Question: What does this figure show? Answer in one sentence.
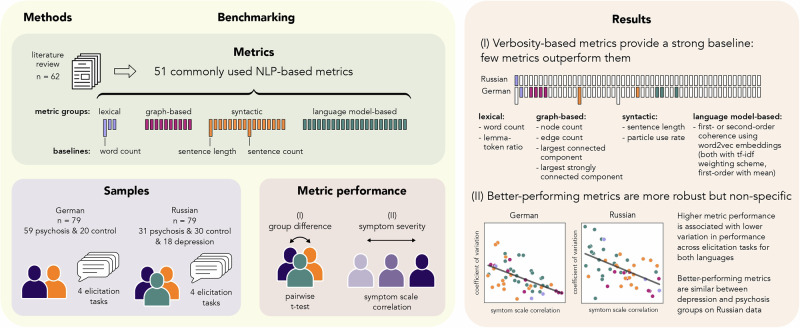
Answer: The study framework for benchmarking the commonly used NLP-based psychosis detection methods and an overview of the main findings. Methods . Samples Two datasets of speech samples were used in this study, one with German and one with Russian-speaking participants. Each sample included a group of participants with psychosis as well as a healthy control group and, for the Russian data, a clinical control group of patients with affective disorders with predominantly depressive symptoms. Four different elicitation tasks were used to obtain four texts per participant. Metric performance Two definitions of metric performance for psychosis detection were used, (i) group difference detection measured with a t-test and (ii) symptom severity assessment measured as correlation with symptom scale scores. Benchmarking 51 commonly used NLP-based metrics were identified through a literature review comprehending 62 papers, proceedings, and thesis reports. The metrics were grouped into lexical, graph-based, syntactic, and language-model-based. Three verbosity-based baselines were selected, namely, word count, sentence count, and mean sentence length. Results The benchmarking identified that only few metrics could outperform the strongest verbosity baseline for symptom severity assessment: graph-based metrics, particle use rate, lemma-token ratio and word2vec first-/second-order coherence for the German sample; no metrics outperformed the strongest baseline for the Russian sample (I). Furthermore, better-performing metrics were more consistent across different elicitation tasks (II).